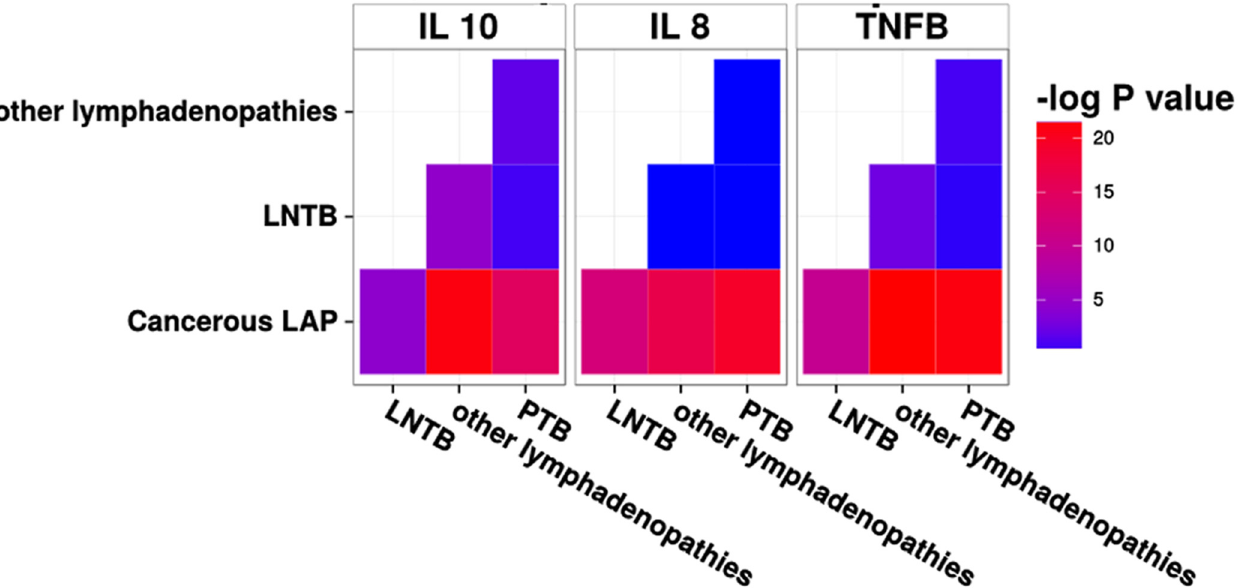
Fig 3. Heatmap of pairwise discriminatory power of individual cytokine in the validation cohort. Each panel is representing a cytokine. Phenotypes are on x and y axes. Each combination of phenotypes is filled by -log p value obtained from Tukey ’ s posthoc testing after ANOVA. If any combination of two phenotypes is filled with red/pink, then the particular cytokine is significantly different between the two groups and thus may help in distinguishing